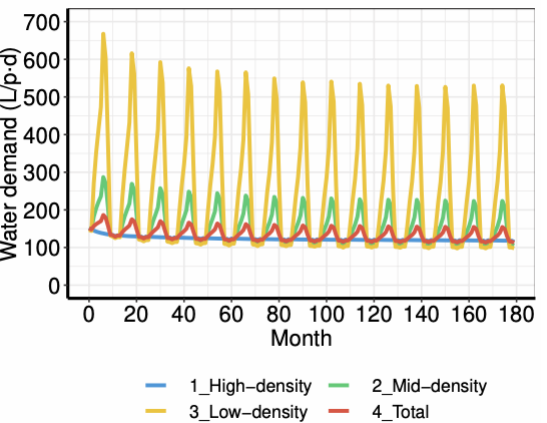
Figure 3. Simulated average water use for each domestic use depending on the housing type in Scenario S1.